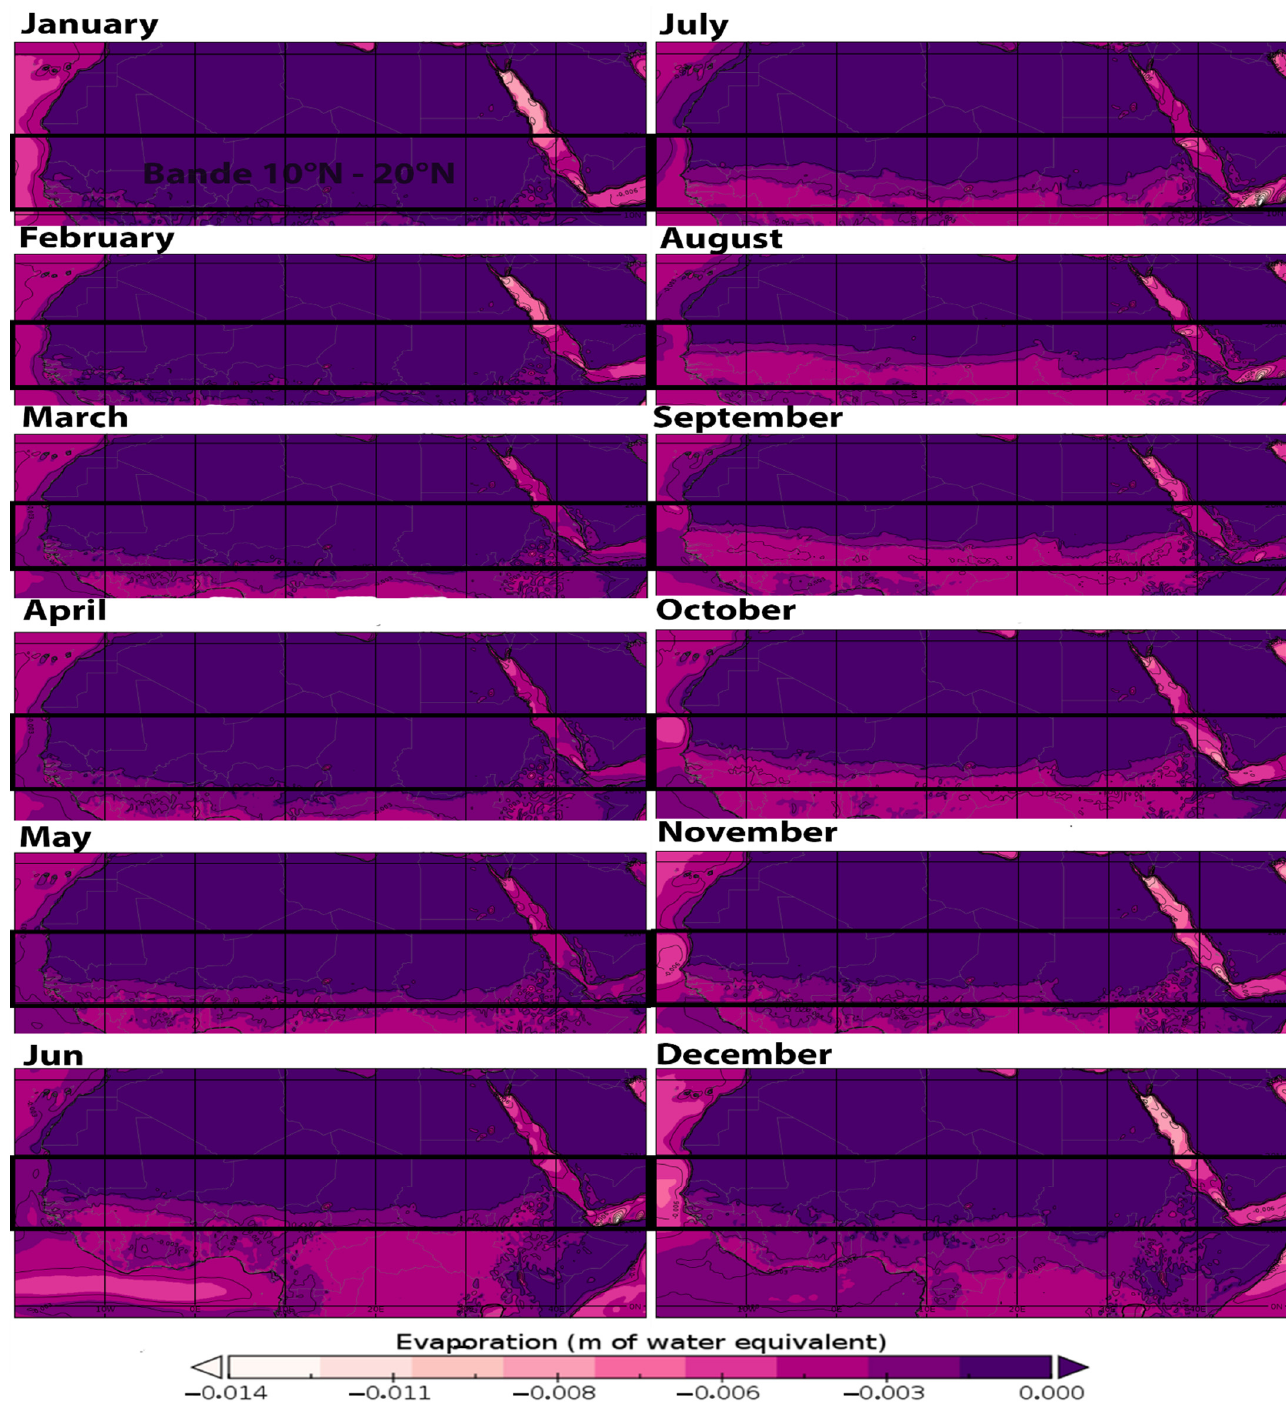
Figure 6. Monthly average evaporation climatology (4D-Var ERA5) in m water equivalent from 1979 to 2008 with a resolution of 0.5 × 0.5 degrees. Data from the ERA5 platform.